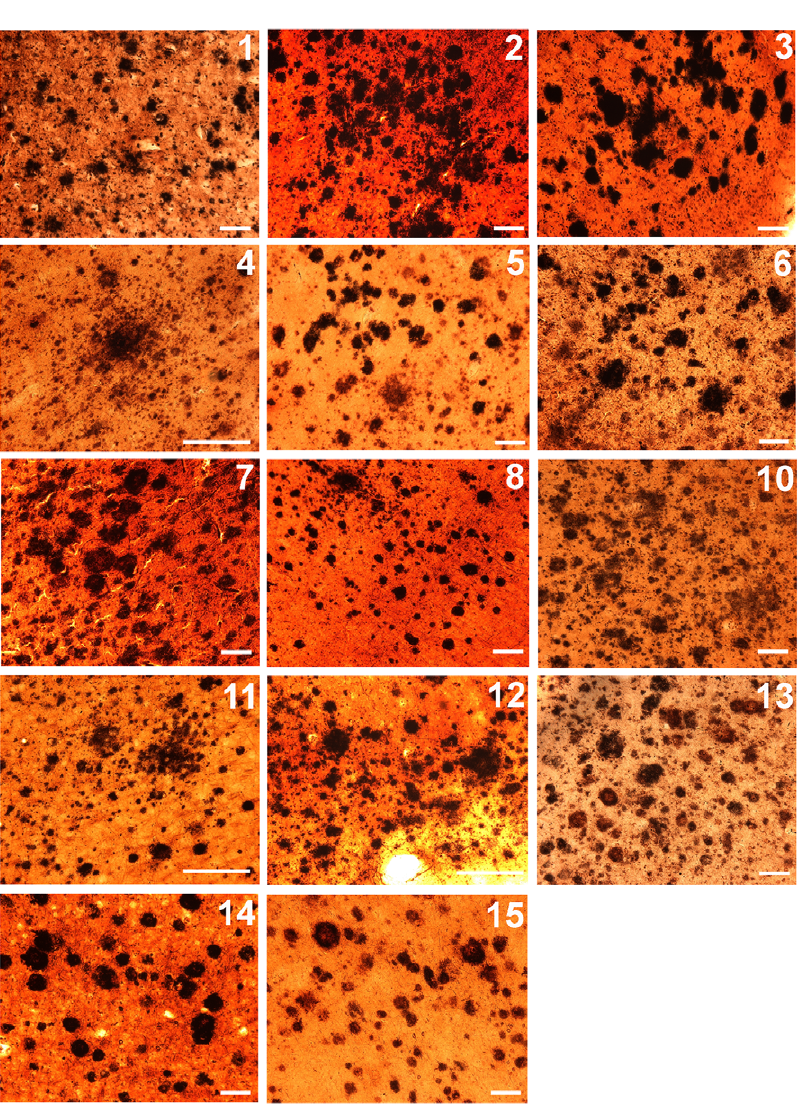
Figure 1. Amyloid plaques stained by the Campbell-Switzer technique. The histological fields are representative of the amyloid plaque burden shown in 40 m m coronal sections of the frontal lobe. The numbers on the top right corners correspond to the case identification numbers given in Table 1 . Scale bars =100 m m.